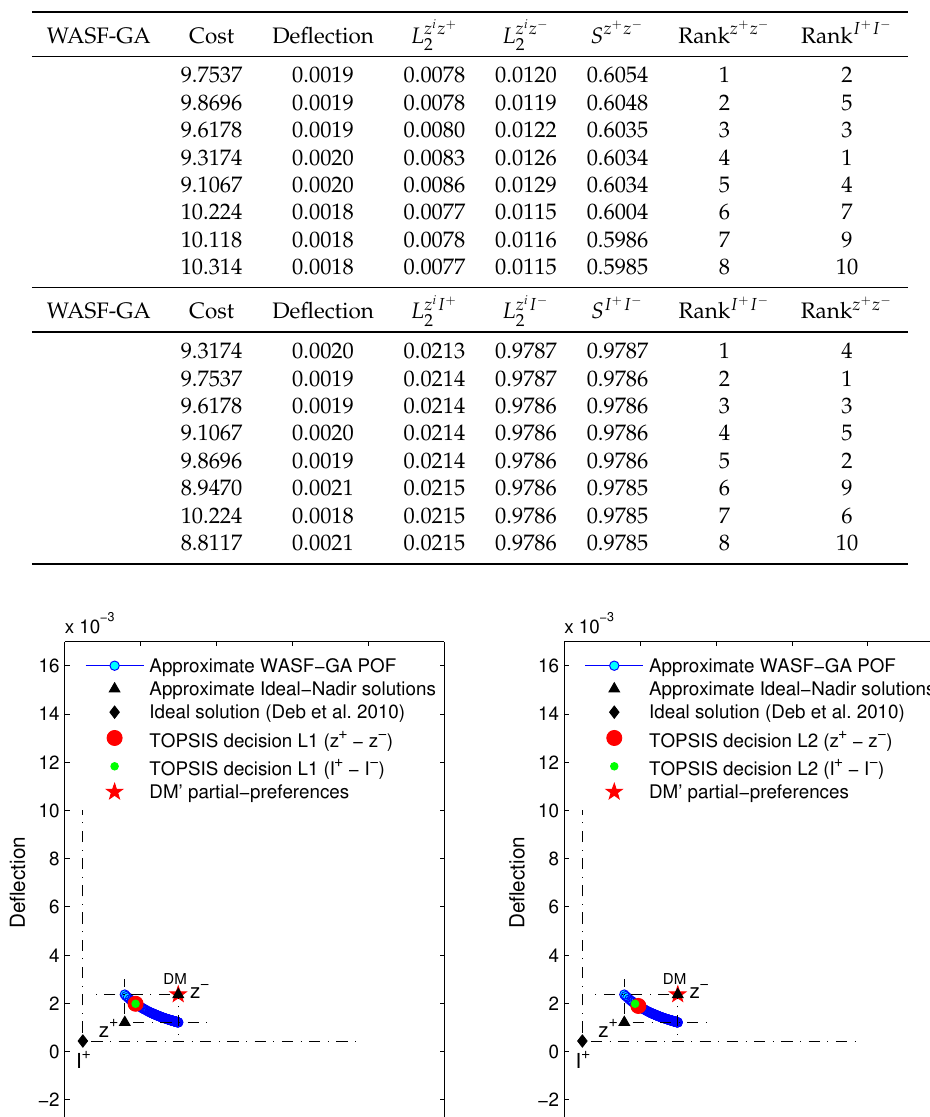
Table 7. TOPSIS ranking results with L 2 metric for WASF-GA, DM’s partial-preferences (15,0.0025) ( N = 100).